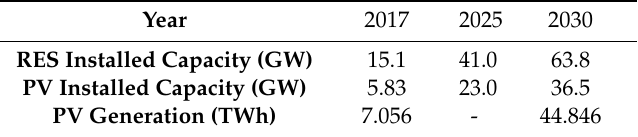
Table 7. Summary of RES, PV installed capacity and PV generation to meet the plans [22].